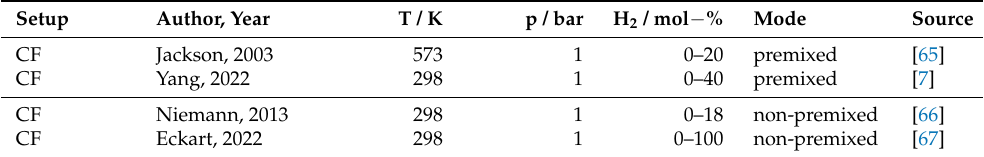
Table 3. Overview of the studies that investigated extinction strain rates for CH 4 /H 2 mixtures. Column H 2 represents the H 2 mole fraction in the fuel mixture of CH 4 /H 2 . CF: